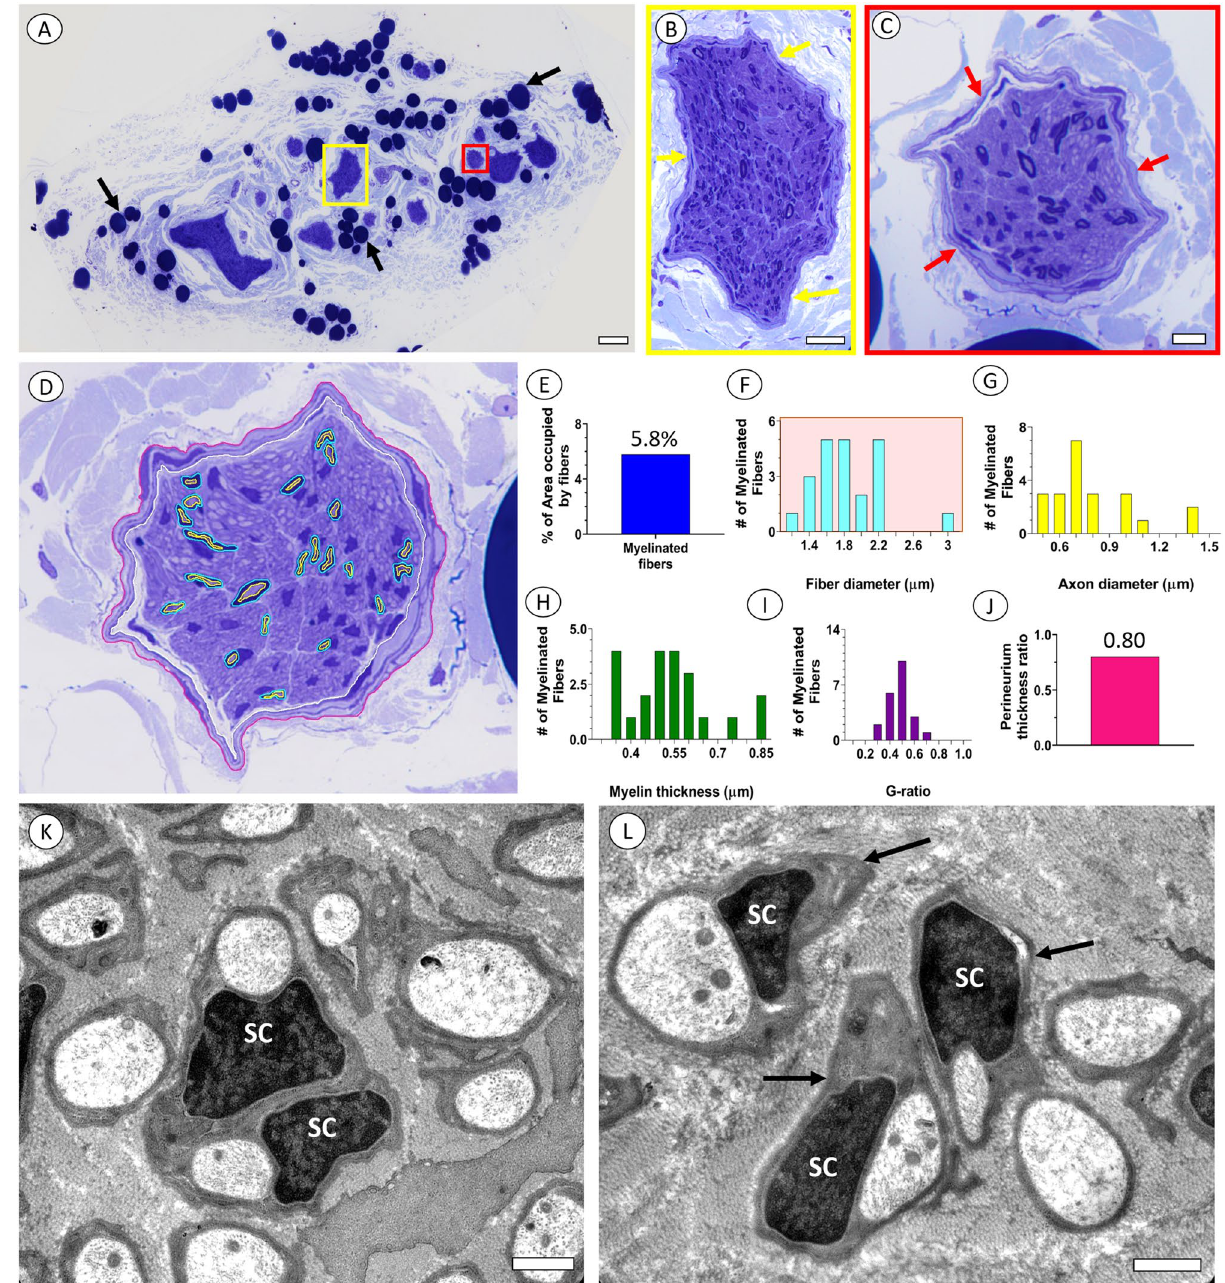
Figure 3. Light and electron micrographs of abdominal and gastric branches of human vagus nerve. ( A ) LM overview of a representative abdominal vagus nerve from a 49 year old female. Note multiple fascicles surrounded by loose connective tissues and lipid droplets (arrows). Scale bar = 100 µm. ( B , C ) Detailed view of individual fascicles indicated by yellow and red boxes in ( A ). Note outline of perineurium of each fascicle (arrows) and intermittent presence of myelinated axons within each fascicle. Scale bar in B = 25 µm; Scale bar in C = 10 µm. ( D ) . Fascicle in ( C ) after segmentation of the inner and outer contours of myelinated axons (n = 22) and perineurium. Quantitative information in ( E – J ) are derived from contoured structures in ( D ). ( E ) Histogram of percent of fascicle area inside of perineurium occupied by myelinated axons. ( F – H) Size distribution of myelinated fiber diameter, axon diameter, and myelin thickness, respectively. ( I ) Distribution of G-ratios for myelinated fibers. ( J ) Histogram of perineurium thickness ratio. ( K , L ) Electron micrographs of unmyelinated axons of the abdominal vagus nerve in 52 year old male. ( K ) Note Remak bundle formed by Schwann cell with nucleus viewed as two portions (SC) in this plane of sectioning and two unmyelinated axons. ( L ) Schwann cell nuclei (SC) with associated unmyelinated axons surrounded by collagen fibers. Note basal lamina (arrows) outlining the cell membrane of each Schwann cell. Scale bar in K, L = 2